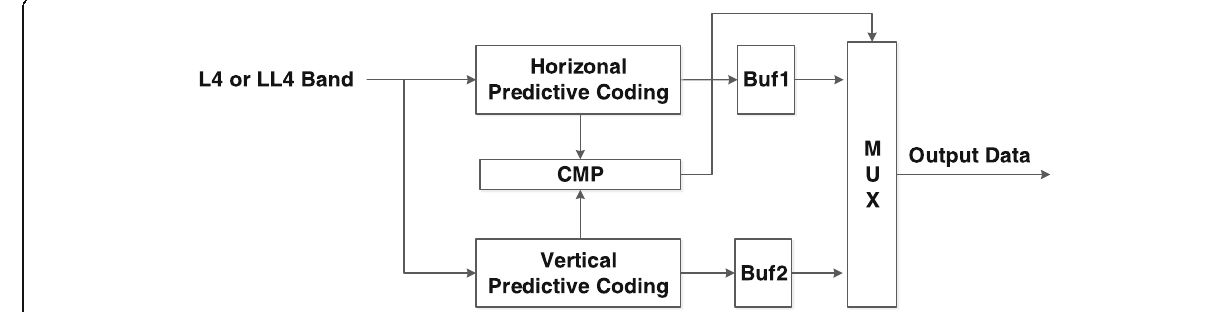
Fig. 7 Optimal predictive coding selection process (horizontal coding or vertical